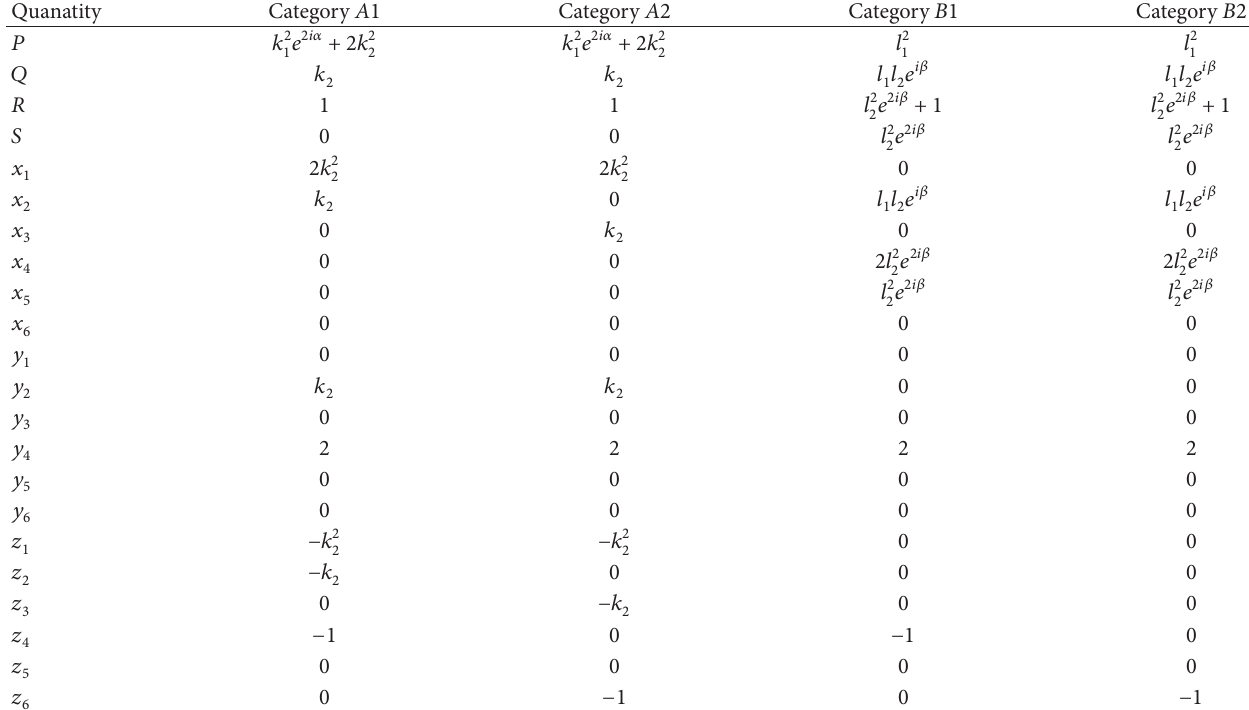
Table 5: Expressions for 𝑃 , 𝑄 , 𝑅 , 𝑆 , 𝑥 1−6 , 𝑦 1−6 and 𝑧 1−6 for Categories 𝐴1 , 𝐴2 , 𝐵1 and 𝐵2 from (47) and (48).